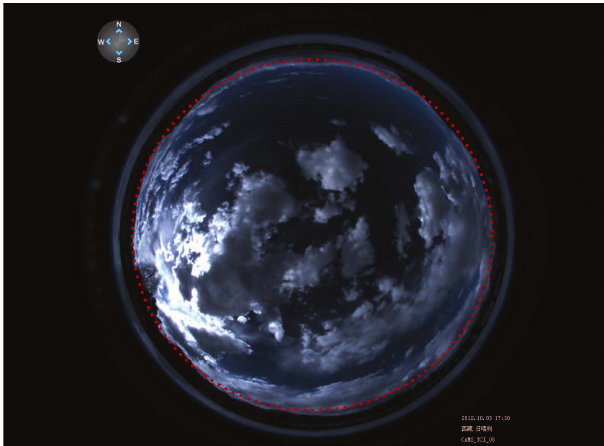
Figure 2. An all-sky image example used in this work (3 Octo- ber 2012, 17:30GMT + 8). The area marked by the red circle refers to the circle of